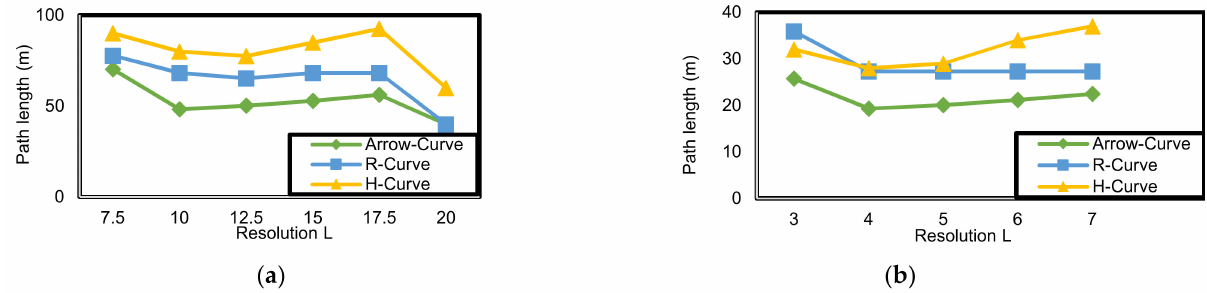
Figure 24. Path length (PL) corresponding to resolution (L) in Arrow-Curve model, R-Curve path model, and H-Curve (outdoor environment): ( a ) outdoor environment; ( b ) indoor environment.